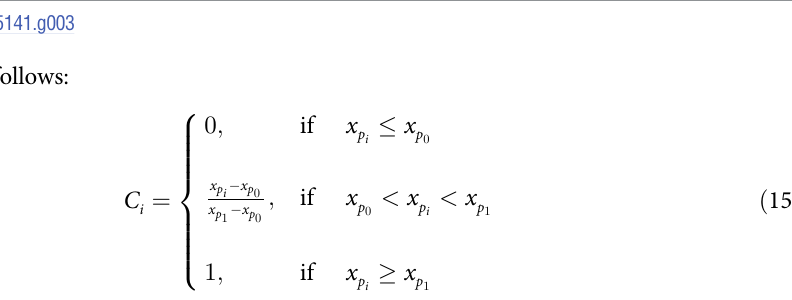
using Eq 17 with θ = 60˚. C: The final colourmap values C i